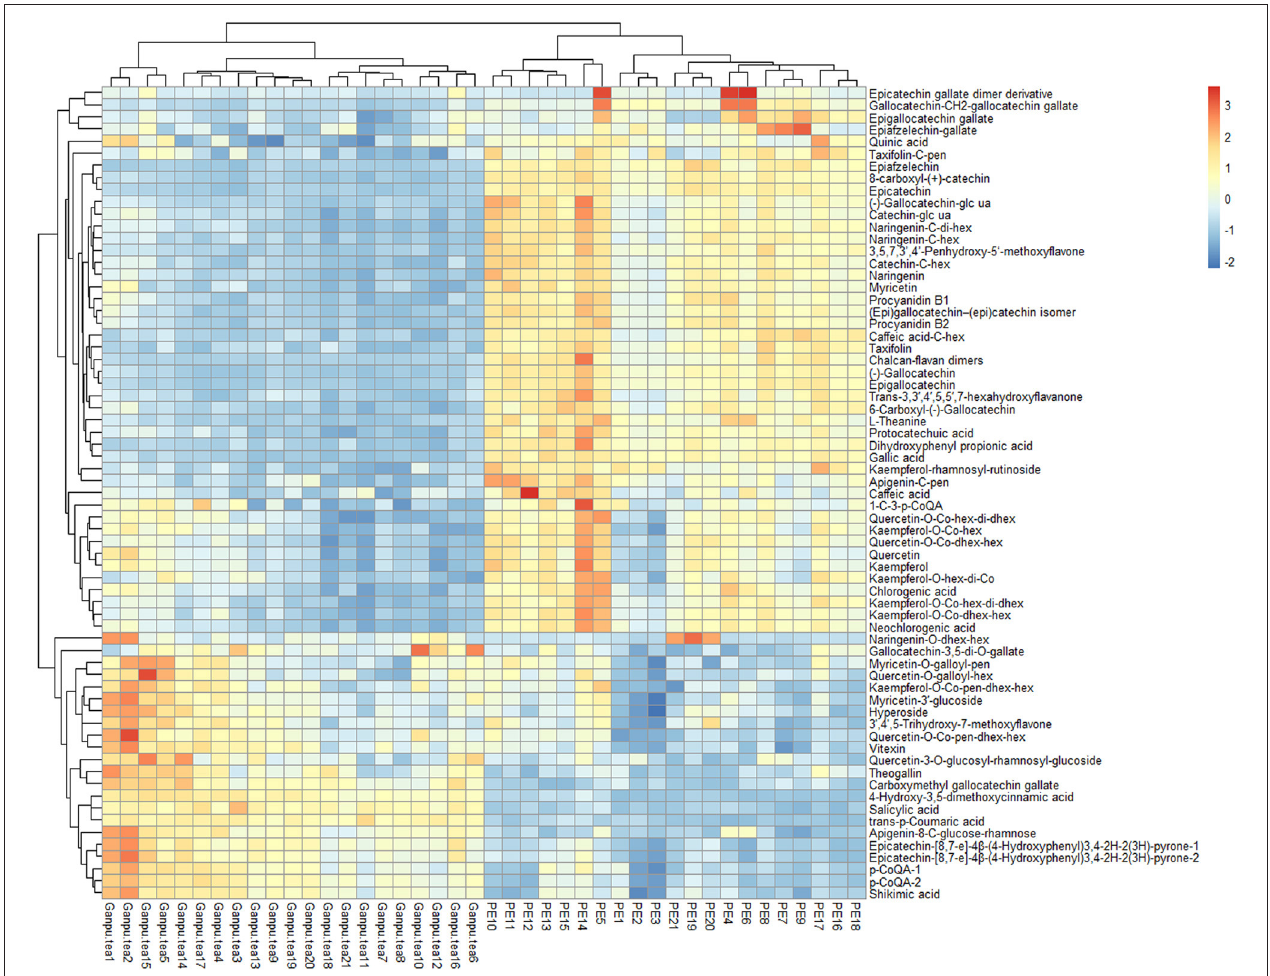
FIGURE 7 | Heatmap constructed by the quantitative data of 67 features. Heatmap shows that Pu-erh tea and Ganpu tea have been